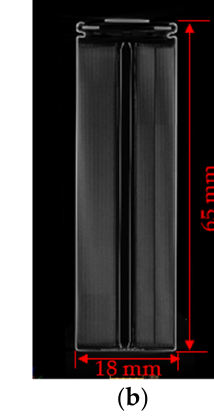
Figure 1. CT scan of 18650 lithium-ion battery: ( a ) cross section; ( b ) longitudinal section.